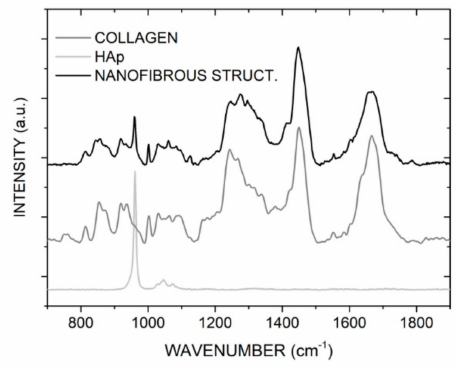
Figure 6. A Raman spectrum of the prepared composite material, including spectra of its individual components (COL, HAp).